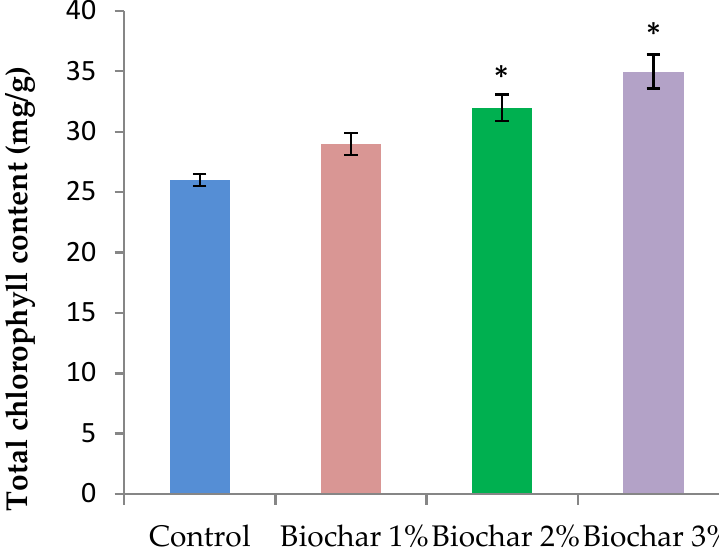
Figure 4. The impact of biochar concentrations on chlorophyll content of ginger. Data are means of three replicates ( n = 3), asterisks indicate significant differences from the control at p < 0.05. In addition, the results on carotenoid contents showed that the biochar additions of 2% and 3% significantly increased the carotenoid content by 30% and 43%, respectively, compared to the control (Figure 5).